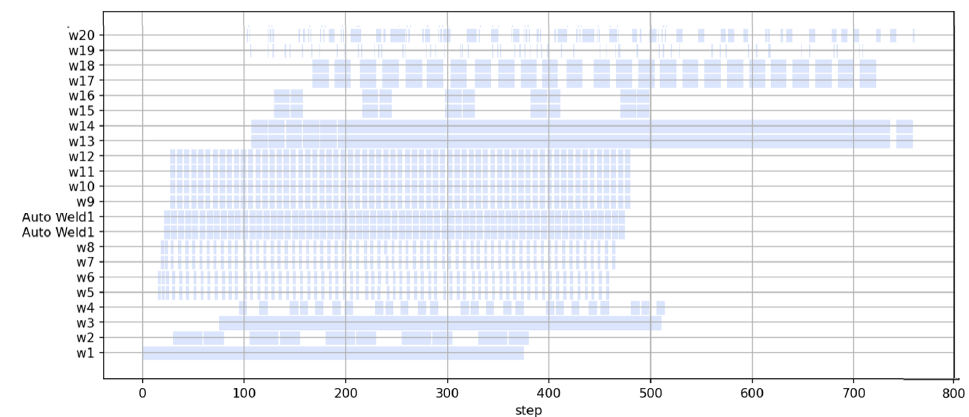
Figure 12. Gantt Chart of Workers in the Original